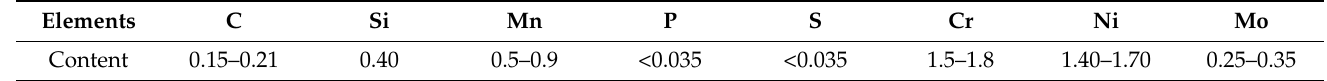
Table 1. Chemical composition of the investigated steel (wt